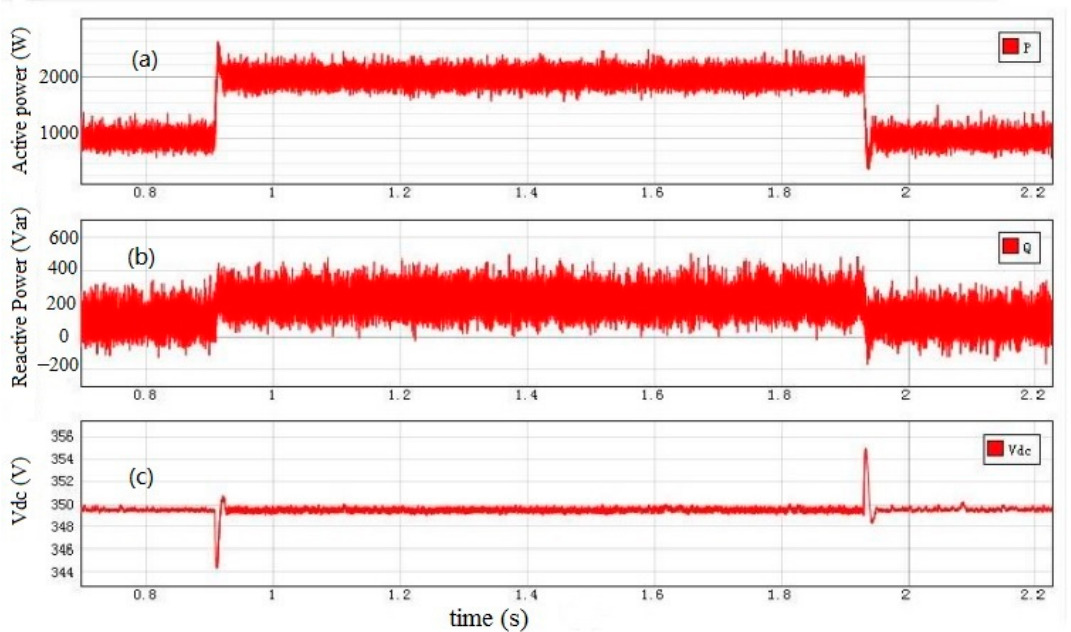
Figure 17. Instantaneous load ‐ unload experiment results. ( a ) Active power; ( b ) Reactive power; ( c ) DC bus voltage.